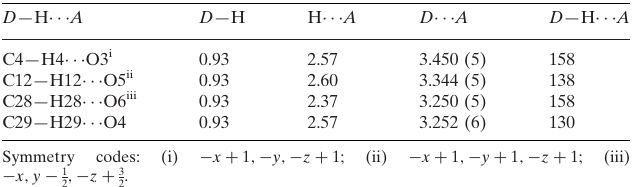
Hydrogen-bond geometry (A˚ , (cid:3)